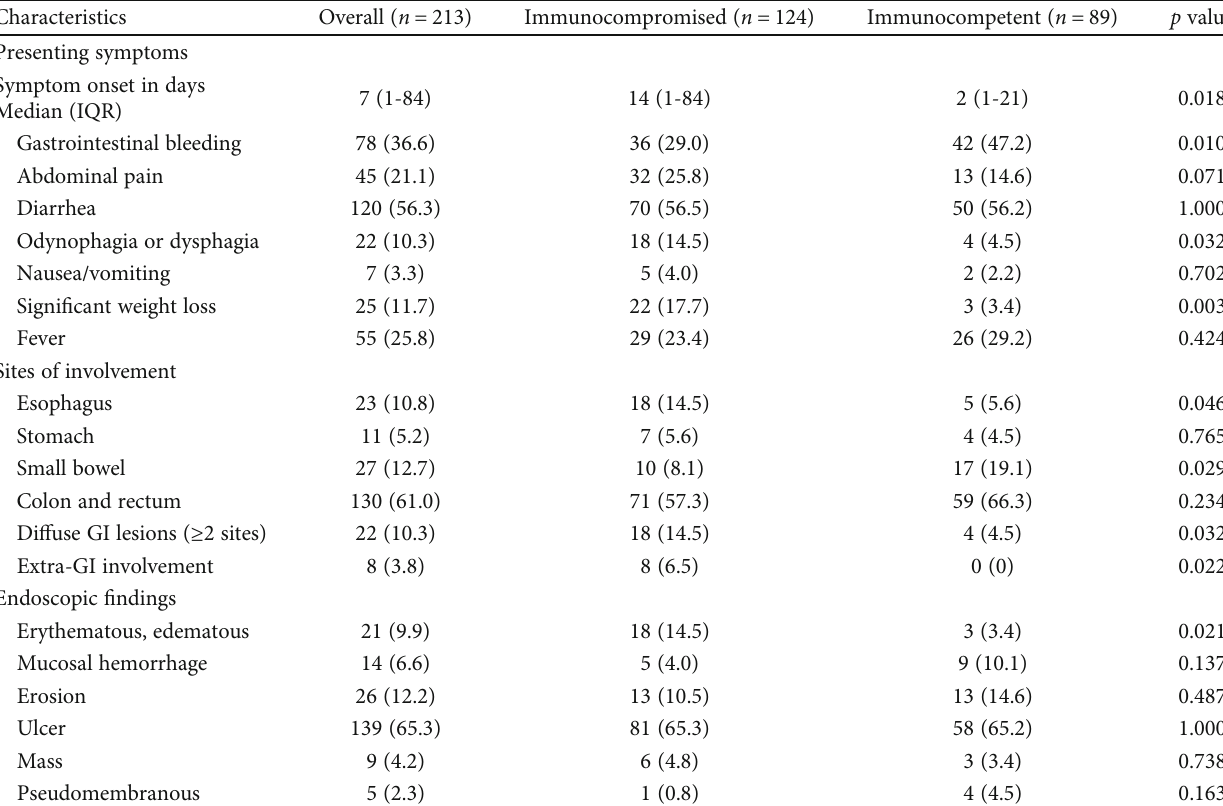
Table 2: The locations and endoscopic fi nding of TI-GI CMV disease between immunocompromised and immunocompetent patients.